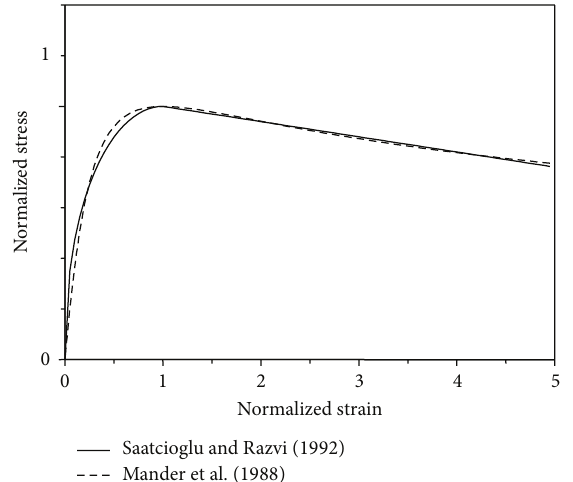
Figure 8: Comparison of results: 𝑀 - 𝜑 curve for given 𝑁 .